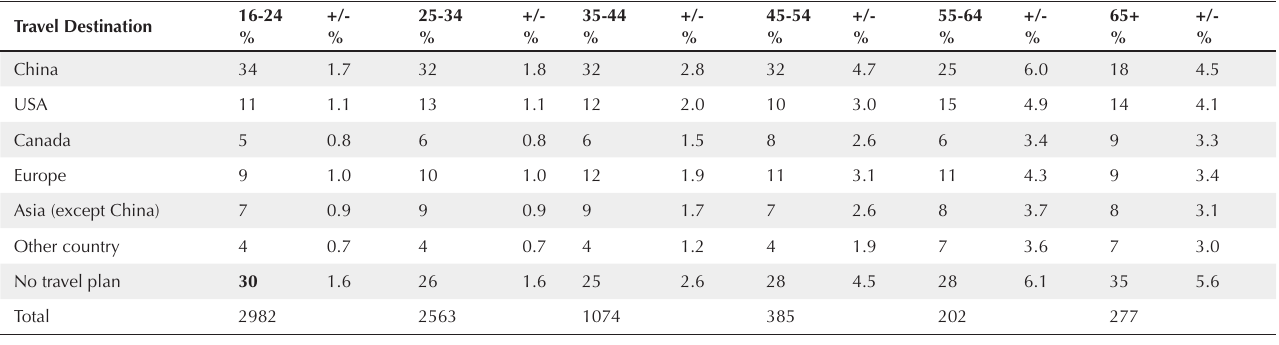
Table 2. Travel Plans by Age Group Travel